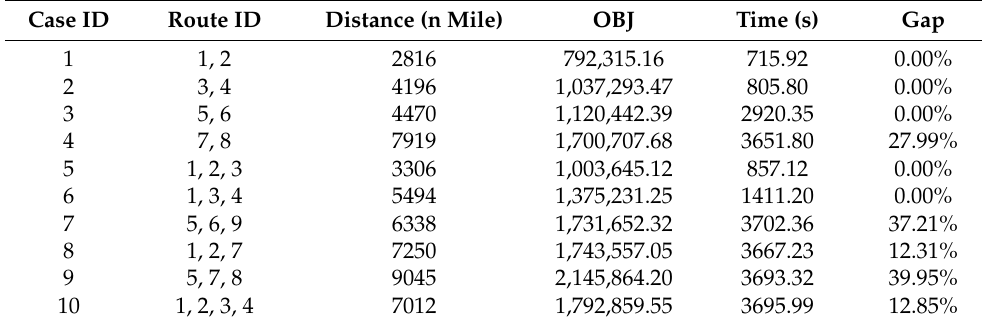
Table 3. Computational results of the basic